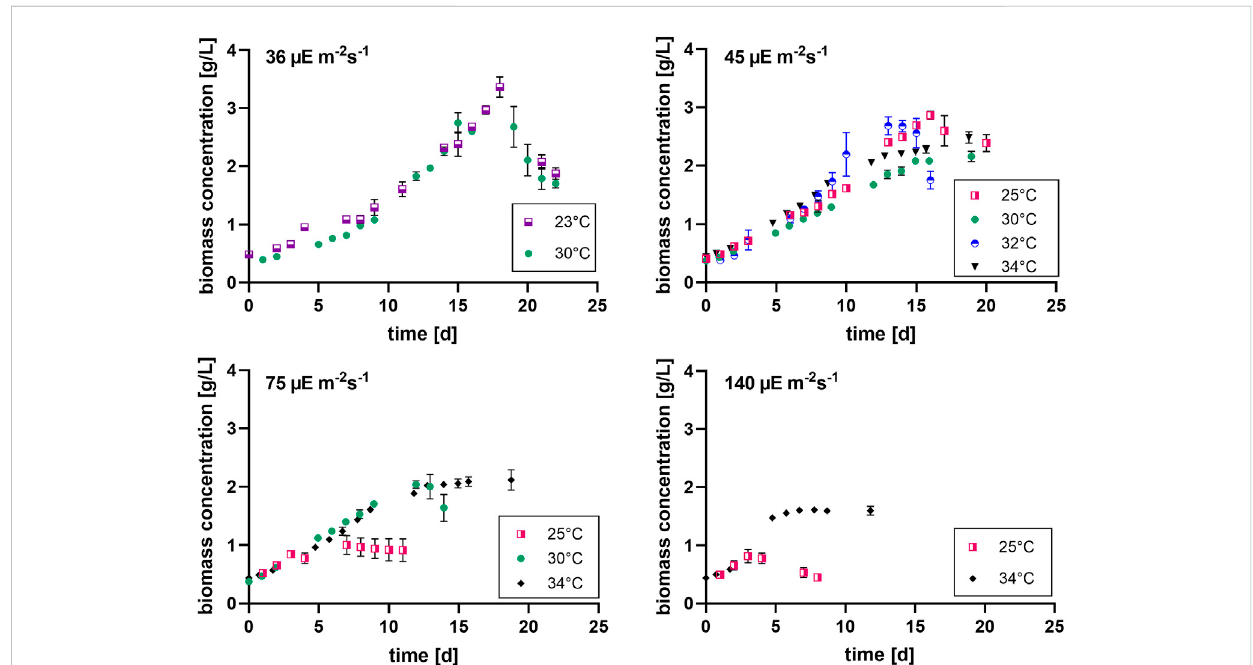
FIGURE 2 Biomass concentration curves at different light intensities (36, 45, 75 and 140 µmol photons m -2 s -1 ) [µE = µmol photons], with n = four to eight, all values are presented as mean ± SD (Tables 3 and 4).